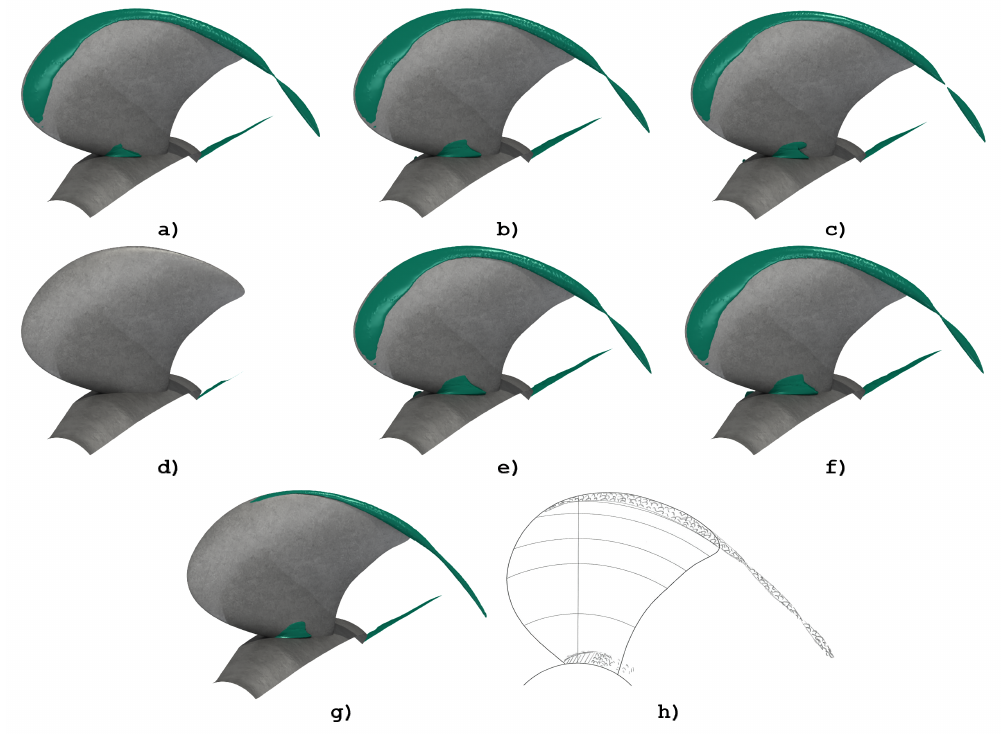
Figure 4. Cavity extents for vapor volume fraction of 0.5 when utilizing various values of parameters C prod and C dest from the literature. ( a ) Bensow et al. [15], ( b ) Morgut et al. [17], ( c ) Kunz et al.